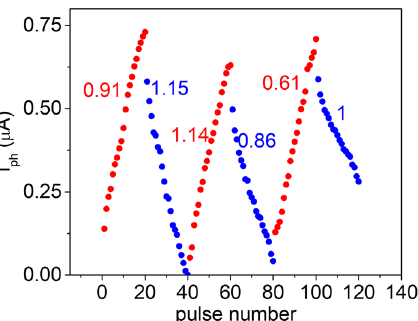
Figure 4. Weight update characteristics. Optical potentiation is obtained with 20 light pulses of t ON = t OFF = 125 ms, λ = 405 nm, V G = 80 V, V TGr = 0.1 V. Electrical depression is obtained in dark, keeping V TGr at 0.1 V, and pulsing the gate voltage from 80 to 70 V, with a pulse width of 125 ms, using 20 voltage pulses. The cycle is repeated 3 times. Non-linearity factors for potentiation and depression are included in the